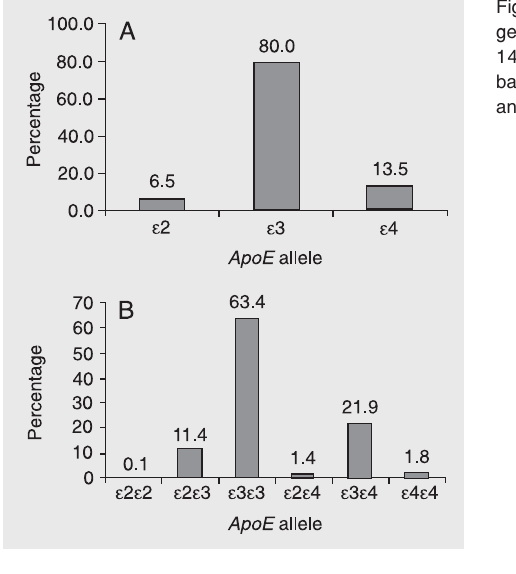
Figure 1. ApoE allele (A) and genotype (B) distribution among 1408 elderly participants at baseline of the Bambuí Health and Aging Study